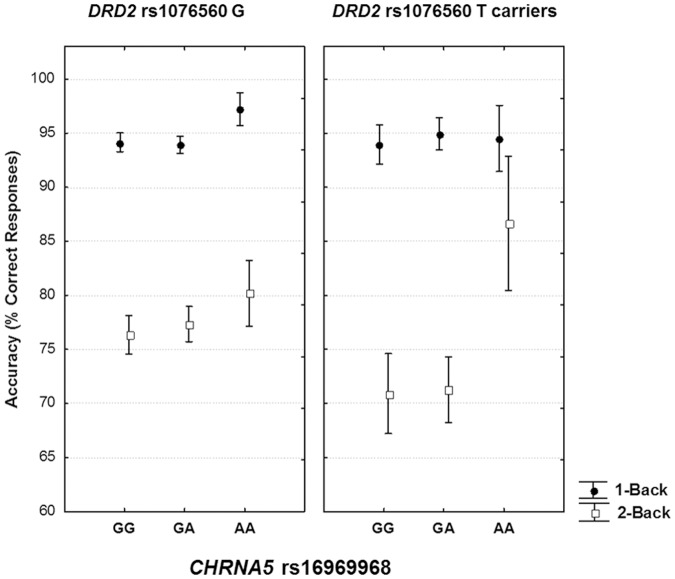
Interaction between Working Memory behavioral performance, DRD2 rs1076560 and CHNRA5 rs16969968 genotypes.Mean ± Standard Errors correct responses (DRD2-GG, left panel; DRD2-Tcarriers, right panel) showing the interaction between the two genotypes. See text for statistics.